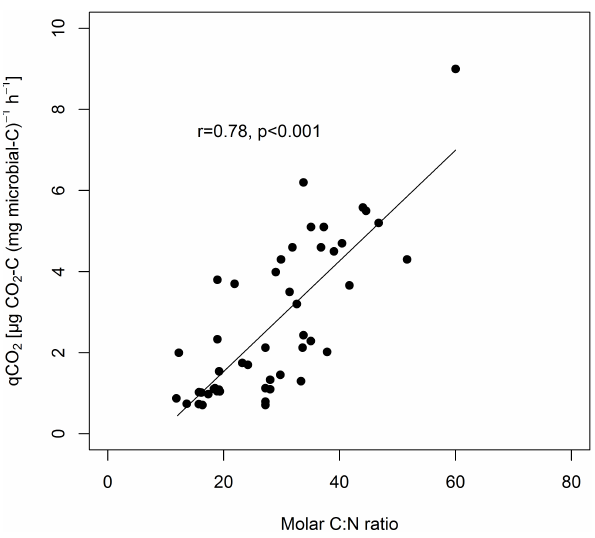
Figure 2. Correlation between the metabolic quotient ( q CO 2 ) and the soil litter layer nitrogen (N) concentration.